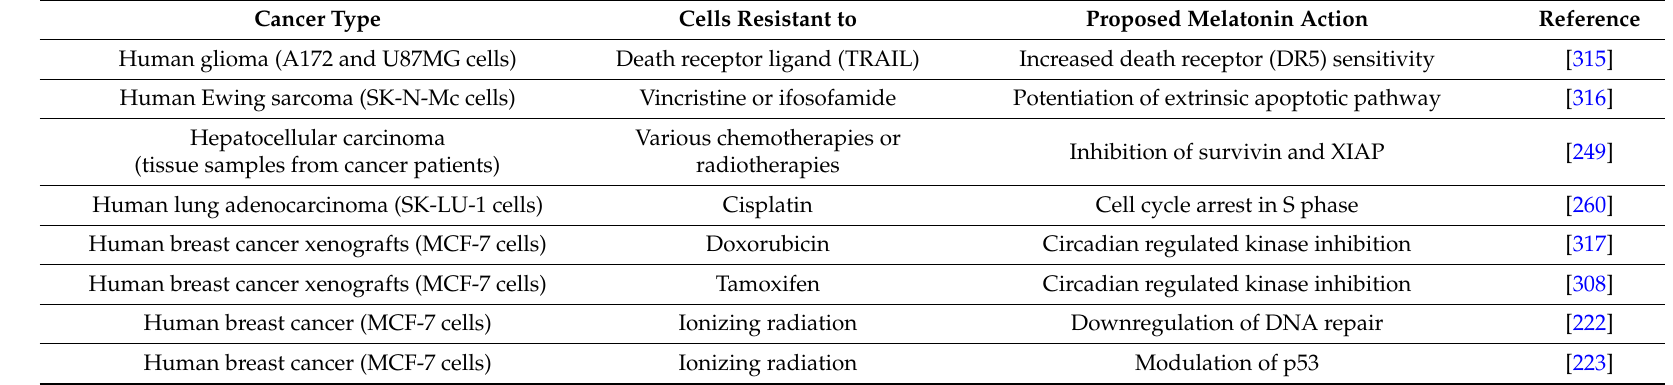
Table 1. Studies in which melatonin administration overcame the resistance of tumors to conventional